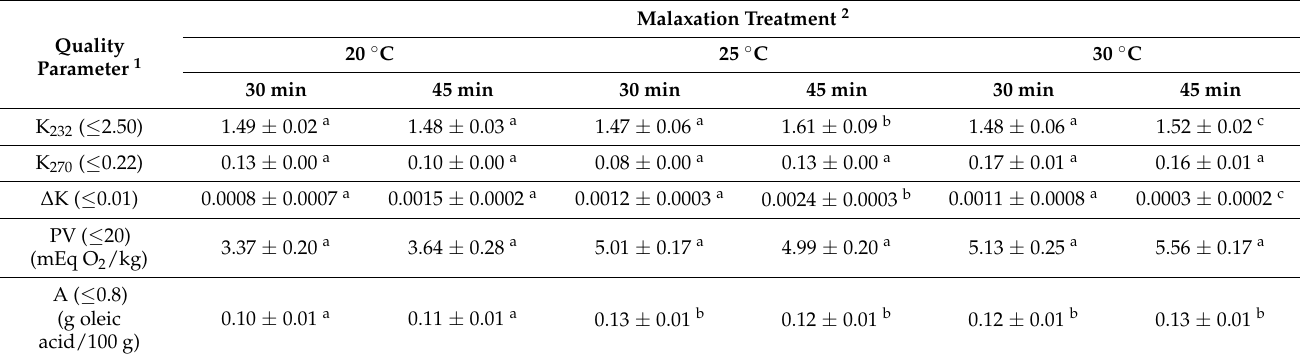
Table 1. Quality parameters (K 232 , K 270 , ∆ K, peroxide value (PV), and acidity(A)) for all olive oil samples. Quality Parameter